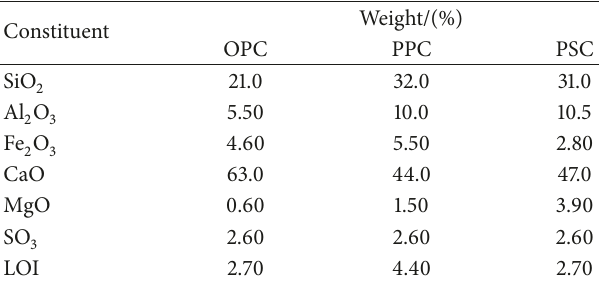
Table 2: Chemical composition of